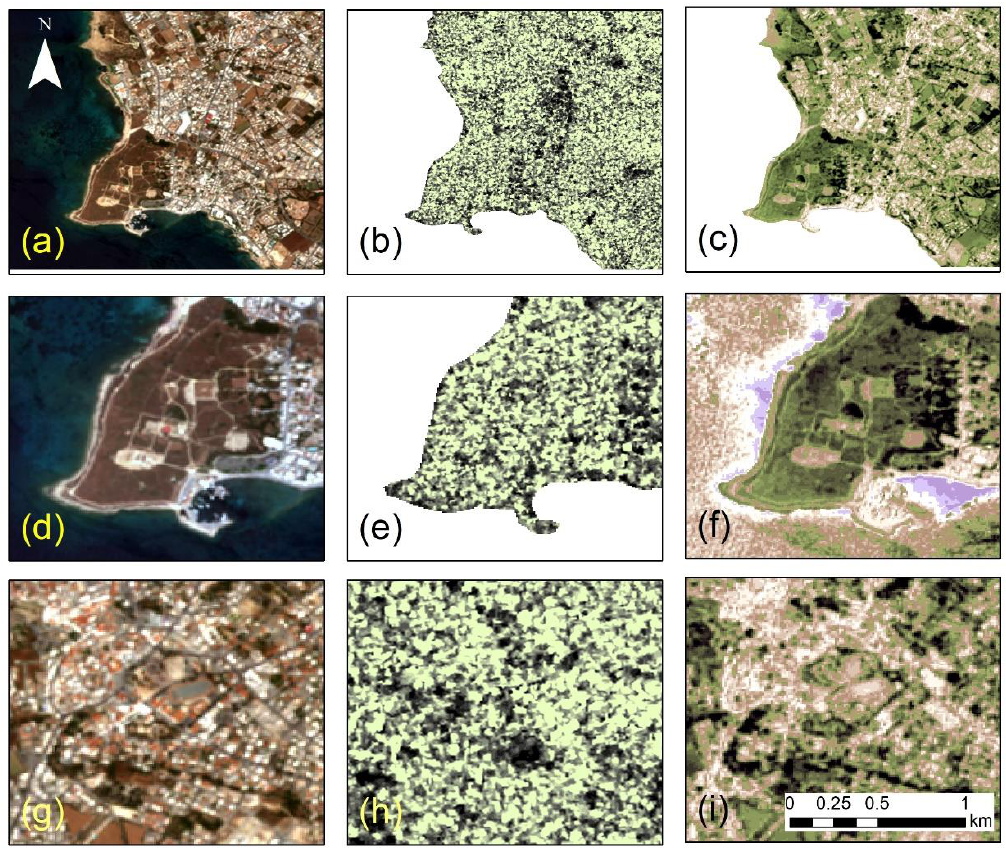
Figure 4. ( a ) Sentinel-2 true colour over the area of interest, ( b ) Radar Vegetation Index (RVI), ( c ) Normalized Difference Vegetation Index (NDVI), ( d ) closer look of (a) over the archaeological site of “Nea Paphos”, ( e ) closer look of ( b ) over the archaeological site of “Nea Paphos”, ( f ) closer look of ( c ) over the archaeological site of “Nea Paphos”, ( g ) closer look of ( a ) over the historical Centre of Paphos town, ( h ) closer look of ( b ) over the historical Centre of Paphos town, and ( i ) closer look of ( c ) over the historical Centre of Paphos town. Vegetated areas are shown with green colour while non-vegetated areas with black colour for the RVI, while for the NDVI vegetation is highlighted with dark green colour.